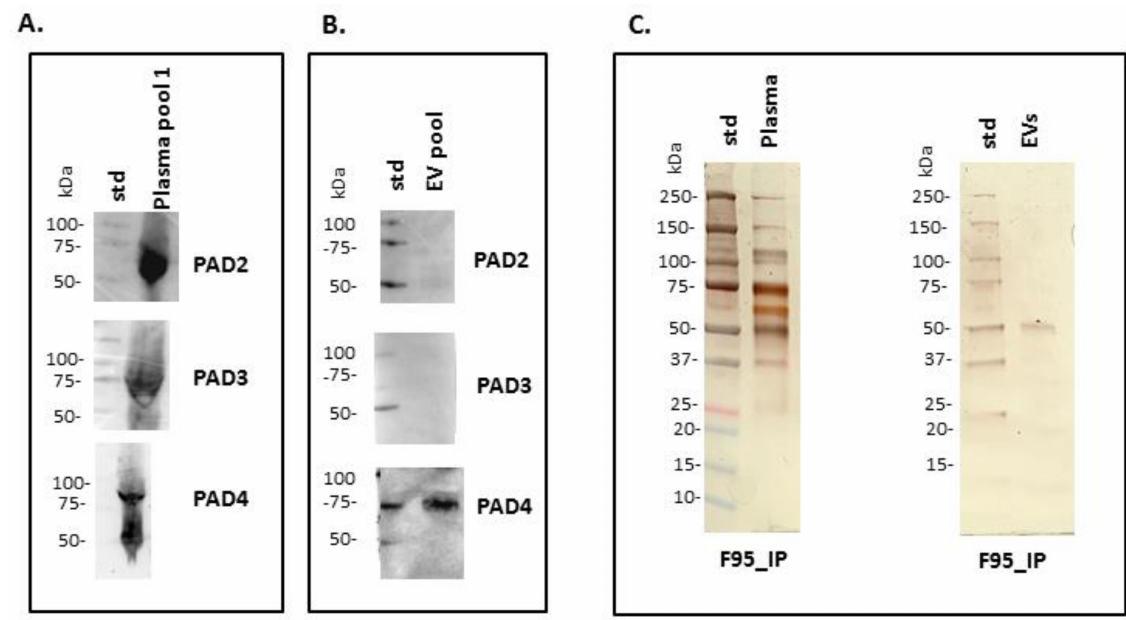
Figure 2. Peptidylarginine deiminase (PAD) isoforms and deiminated proteins in reindeer plasma and plasma EVs. ( A ) Positive bands identified in reindeer plasma at expected size range of approximately 70–75 kDa using anti-human PAD2- , PAD3- and PAD4-specific antibodies (a pool of five plasma is represented). ( B ) In plasma EVs, PAD2 and PAD3 isozymes were not detected while a strong positive reaction for PAD4 was observed (EV pool from five animals). ( C ) F95-enriched IP fractions, representative of deiminated protein enrichment and isolated from reindeer plasma and plasma EVs, were stained with silverstaining following SDS-PAGE in 4–20% TGX gels. The protein size standard (std) is indicated on the blots and gels in kilodaltons